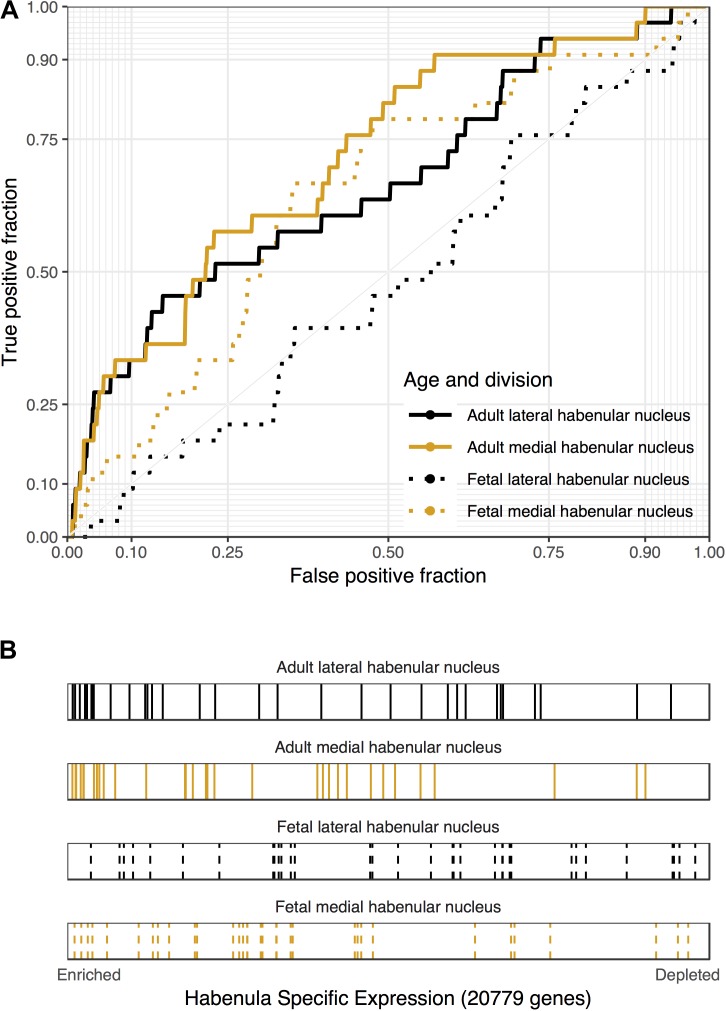
Associations between genes that are down-regulated in the blood of people with high levels of hedonic well-being and habenular specific expression. (A) ROC curves showing the proportion of hedonia down-regulated genes that overlap (y-axis, true positive fraction) in varying lengths of the habenula specific gene rankings (approximated by the x-axis, false positive fraction). (B) Distributions of the hedonia down-regulated genes across the habenular specific gene rankings with each gene representing a single colored line. Color marks the lateral (black) and medial (orange) habenula rankings. Dashed lines are used for the fetal datasets.